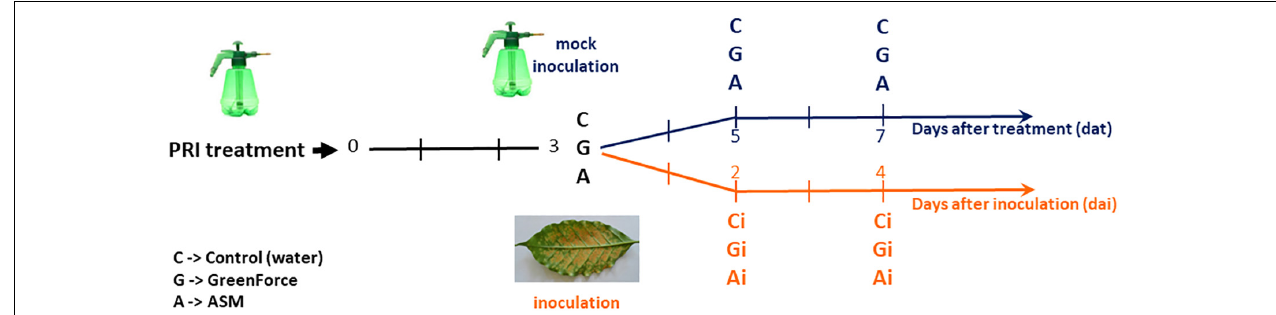
FIGURE 1 | Experimental design – Coffea arabica cv. Mundo Novo leaves were either treated with the PRIs, ASM (A) and Greenforce CuCa (G) or subsequently inoculated with Hemileia vastatrix (Ai, Gi). Leaves were collected at 3, 5, and 7 days after PRIs treatment (black timeline) and at 2 and 4 days after H. vastatrix inoculation (orange timeline). Leaves treated with water were used as control: mock-treated/inoculated (C) or inoculated (Ci).